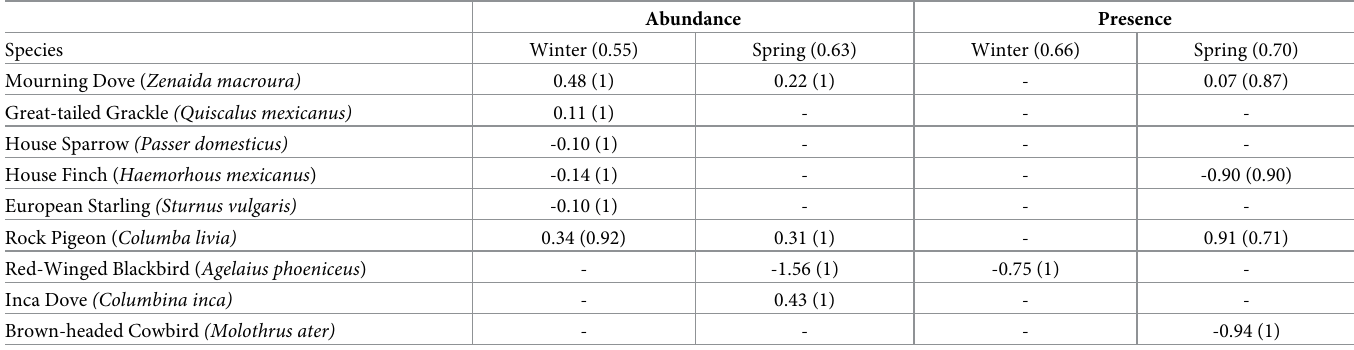
Table 2. The beta estimates for the influence of restaurants on species abundance and species presence for winter and spring. The maximum relative importance value based on null model predictions is presented next to the abundance and presence columns. Beta estimates are from averaged models where the relative importance exceeds the null (see S2–S5 Tables, for full model details). The relative importance value for restaurants is presented next to the beta estimates. Dashes indicate the relative importance value for restaurants below the null model